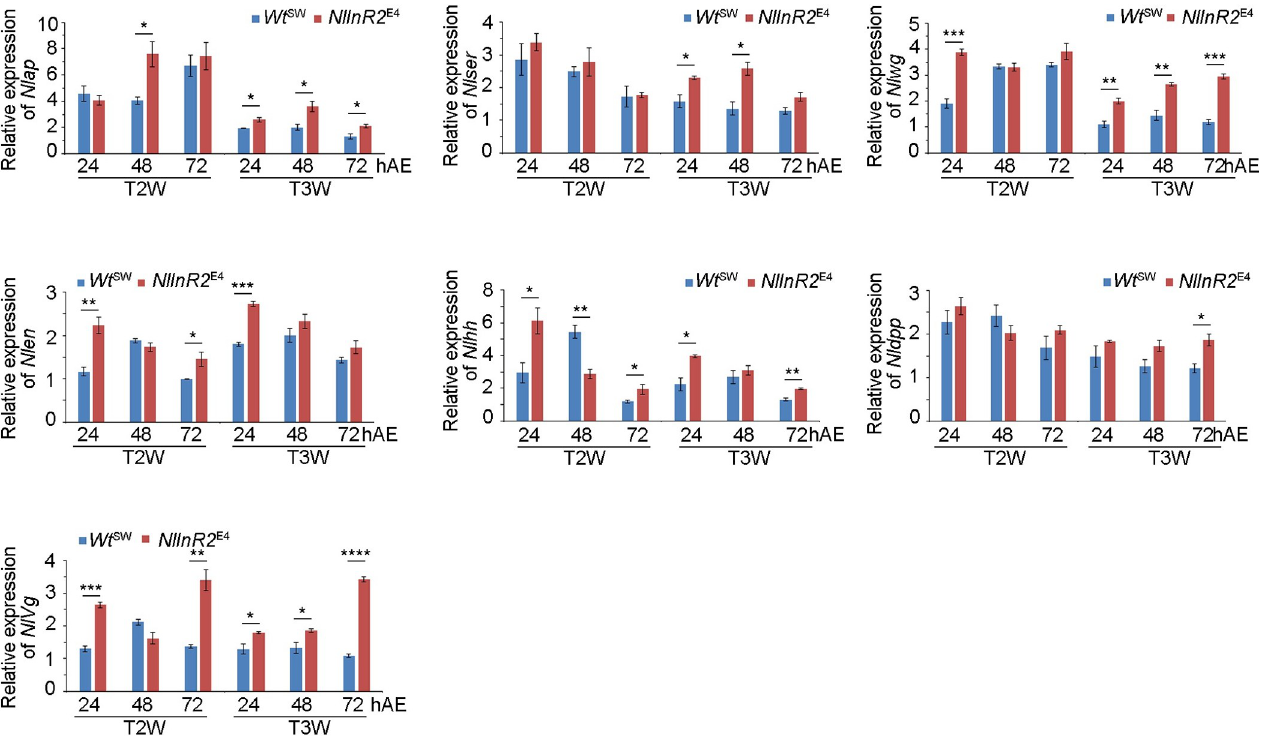
Fig 6. Expression of wing-patterning genes in NlInR2 -null mutants during the 5 th -instar stage. T2W and T3W were dissected from 24, 48, and 72 hAE 5 th - instar NlInR2 E4 and Wt SW nymphs ( n = 150), and total RNA was isolated for qRT-PCR. Relative expression of each gene was normalized by rps15 . Bars represent mean ± s.e.m. derived from three independent biological replicates. Statistical comparisons between two groups were performed using two-tailed Student’s t -test ( � , P < 0.05, �� , P < 0.01, and ��� , P < 0.001). Nlap , N . lugens apterous homologue; Nlser , N . lugens serrate homologue; Nlwg , N . lugens wingless homologue; Nlen , N . lugens engrailed homologue; Nlhh , N . lugens hedgehog homologue; Nldpp , N . lugens decapentapleigic homologue; Nlvg , N . lugens vestigial